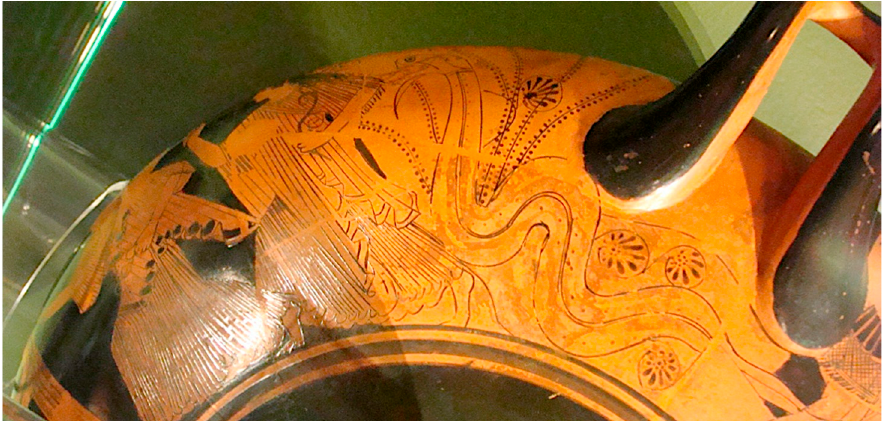
Figure 6. Discovery of Erichthonios. Snake and Aglaurids (Frankfurt, Liebieghaus inv. no. STV7); red-figure cup; signed by Brygos; Attica (from Vulci); ca. 460 BCE . [© The author].